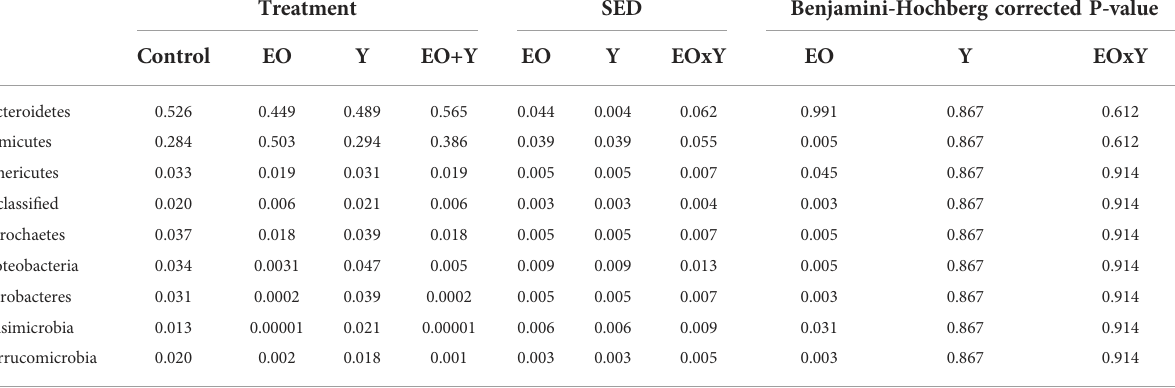
TABLE 6 Effect of supplementing a control diet (C) with oregano oil (EO), yeast (Y) or a combination of both (EO+Y) on the relative abundance of bacteria phyla present at an average of more than 0.5% (false discovery rate for Benjamini-Hochberg:0.25). Treatment SED Benjamini-Hochberg corrected